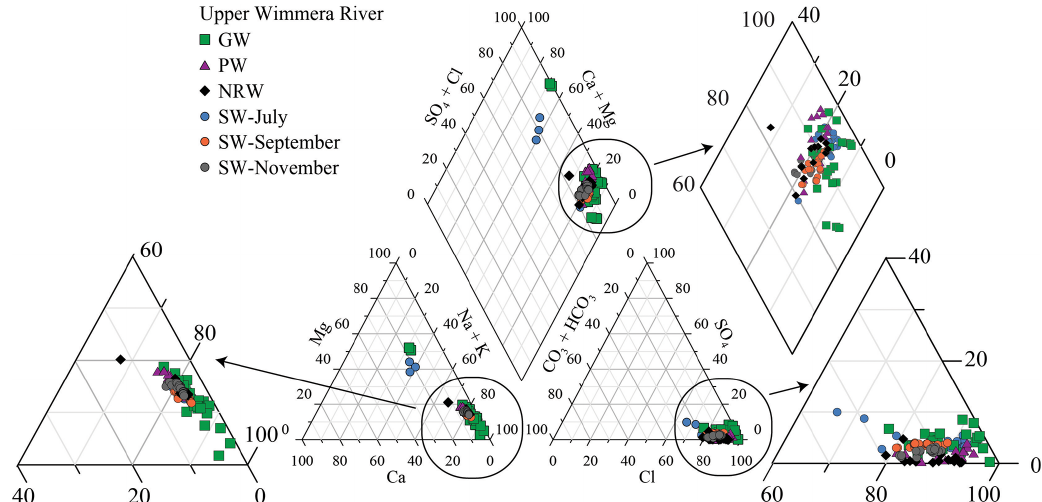
Figure 3. Trilinear diagram summarising molar major ion ratios of the different water sources in the upper Wimmera River (data from Tables S1 and S2). GW = groundwater; PW = pool water; NRW = near river water; SW = stream water. Inserts show details of the data.